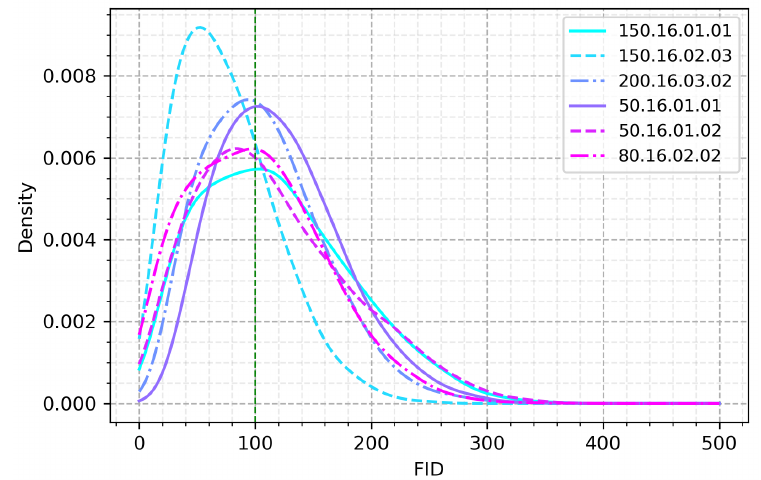
Figure 7. Trained networks: FID distribution over the validation